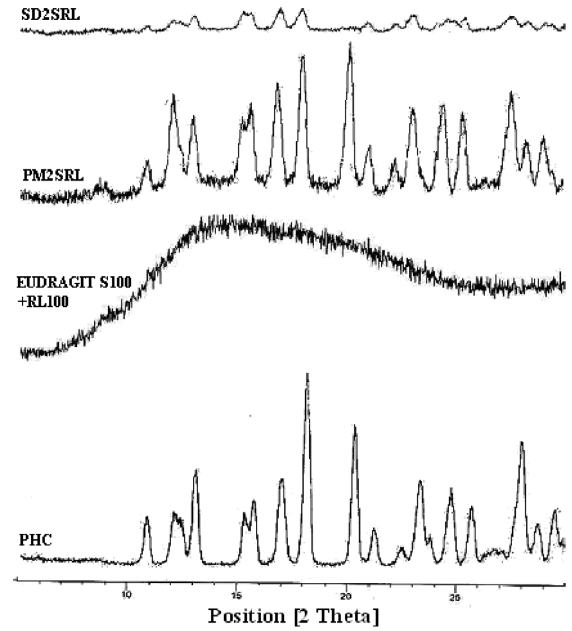
FIGURE 6 - Comparative DSC Thermograms of Pure drug, polymers, PM2SRL and SD2SRL. FIGURE 7 - Powder X-Ray Diffraction Patterns of Pure drug,